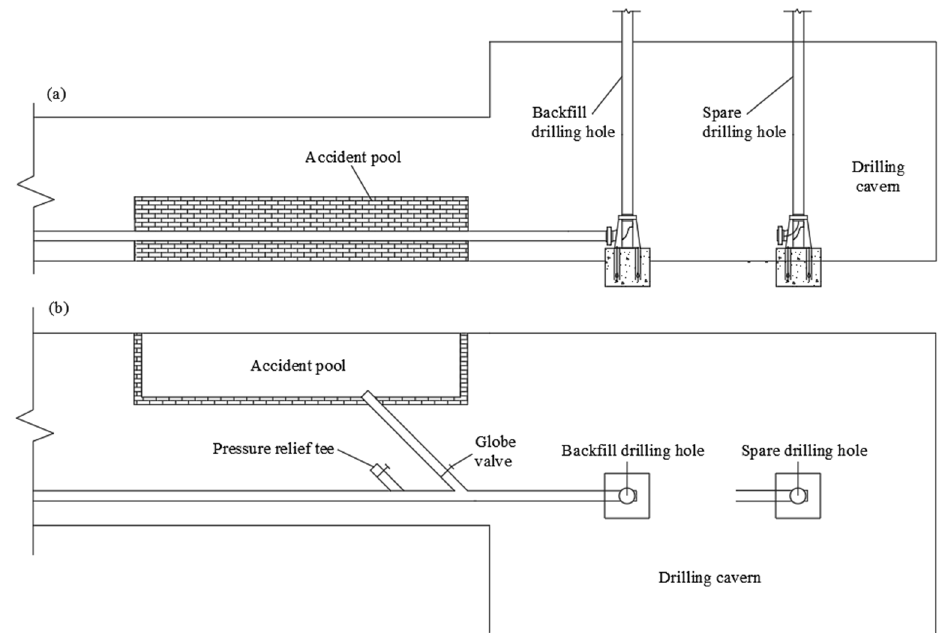
Figure 5. Layout of filling borehole and horizontal pipeline connecting accident treatment valve and accident pool: ( a ) Main view; ( b ) Top view.